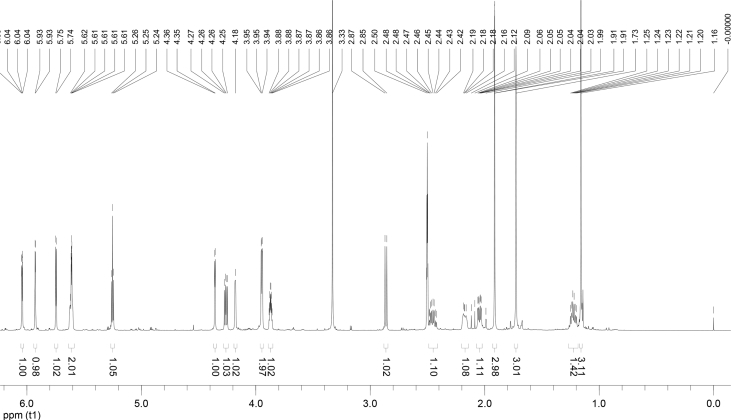
1H NMR (DMSO-d6) spectrum of compound 5.